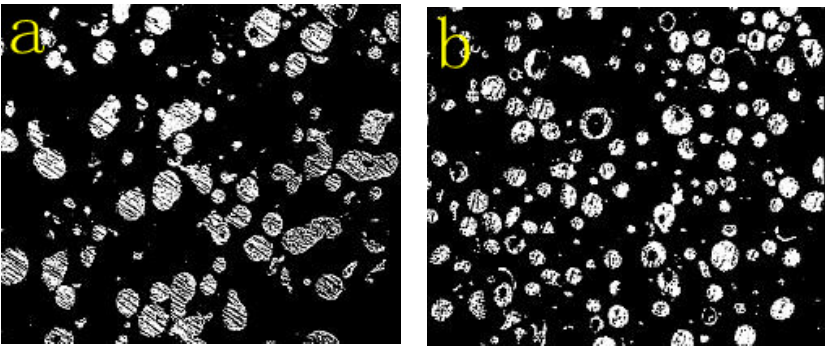
Figure 2. Cross ‐ section of ( a ) NiCrMoY powders and ( b ) Ni60A powders.